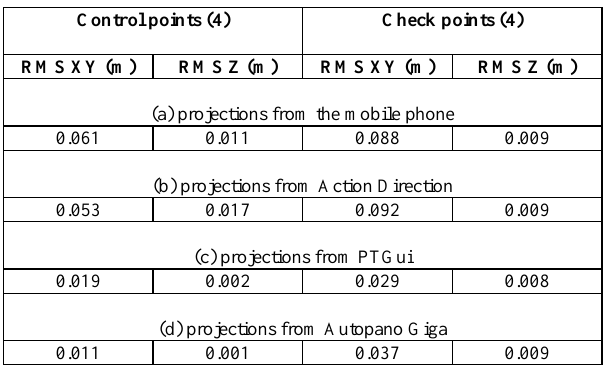
Table 2. The statistics for control points and check points with the equirectangular projections generated with different solutions.